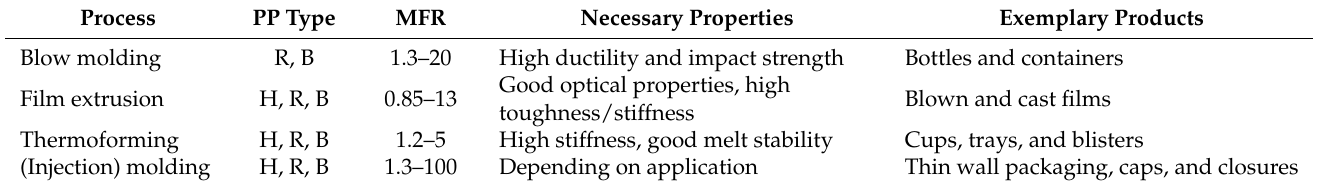
Table 1. Overview of typical types (i.e., H for homopolymers, R for random copolymers, and B for block copolymers) of PP and their corresponding MFR ranges (given in g/10 min) for four different processing methods together with properties required for specific packaging applications. Data are taken from